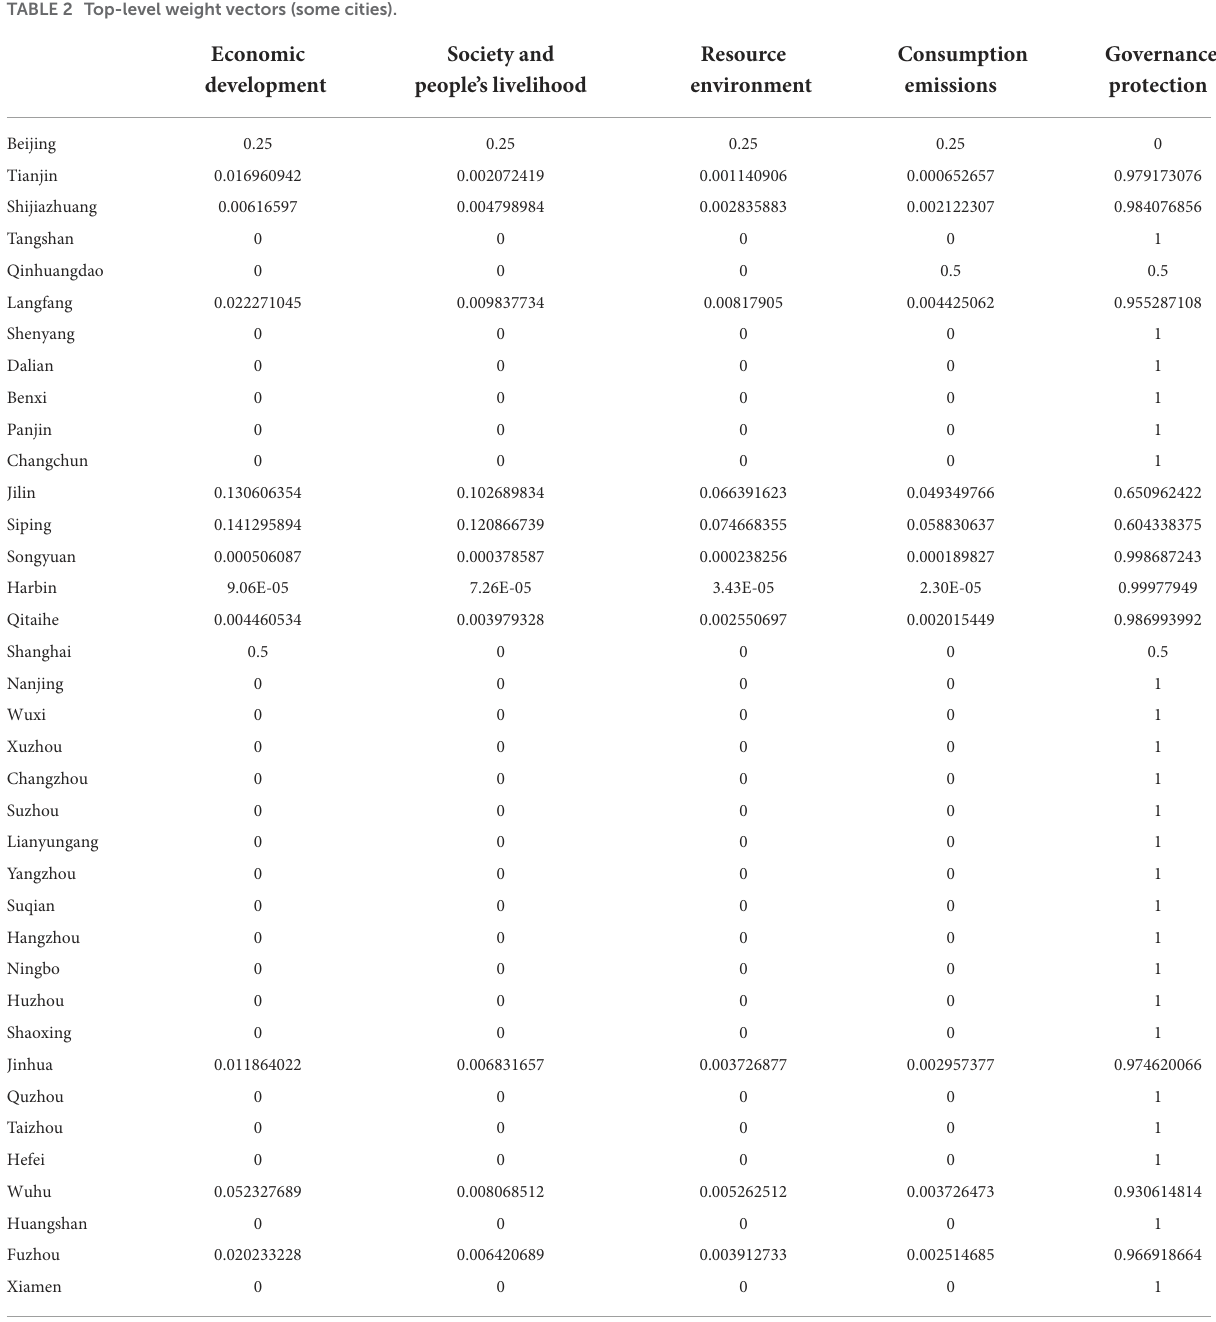
TABLE 2 Top-level weight vectors (some cities).